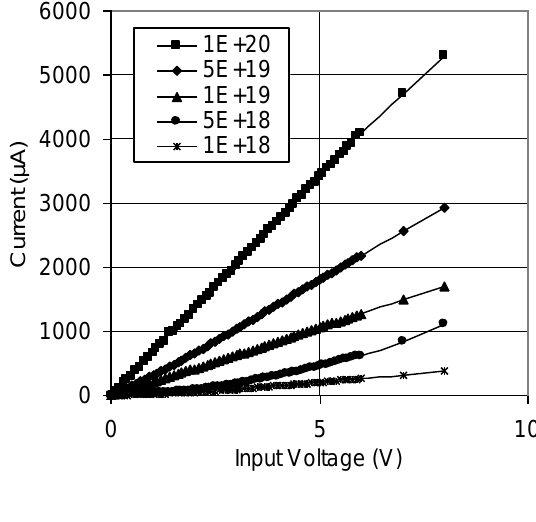
Figure 15. I-V characteristic curve of the developed MEMS sensor at room temperature. The linear relationship indicates good ohmic contact between aluminum metallization and p-type